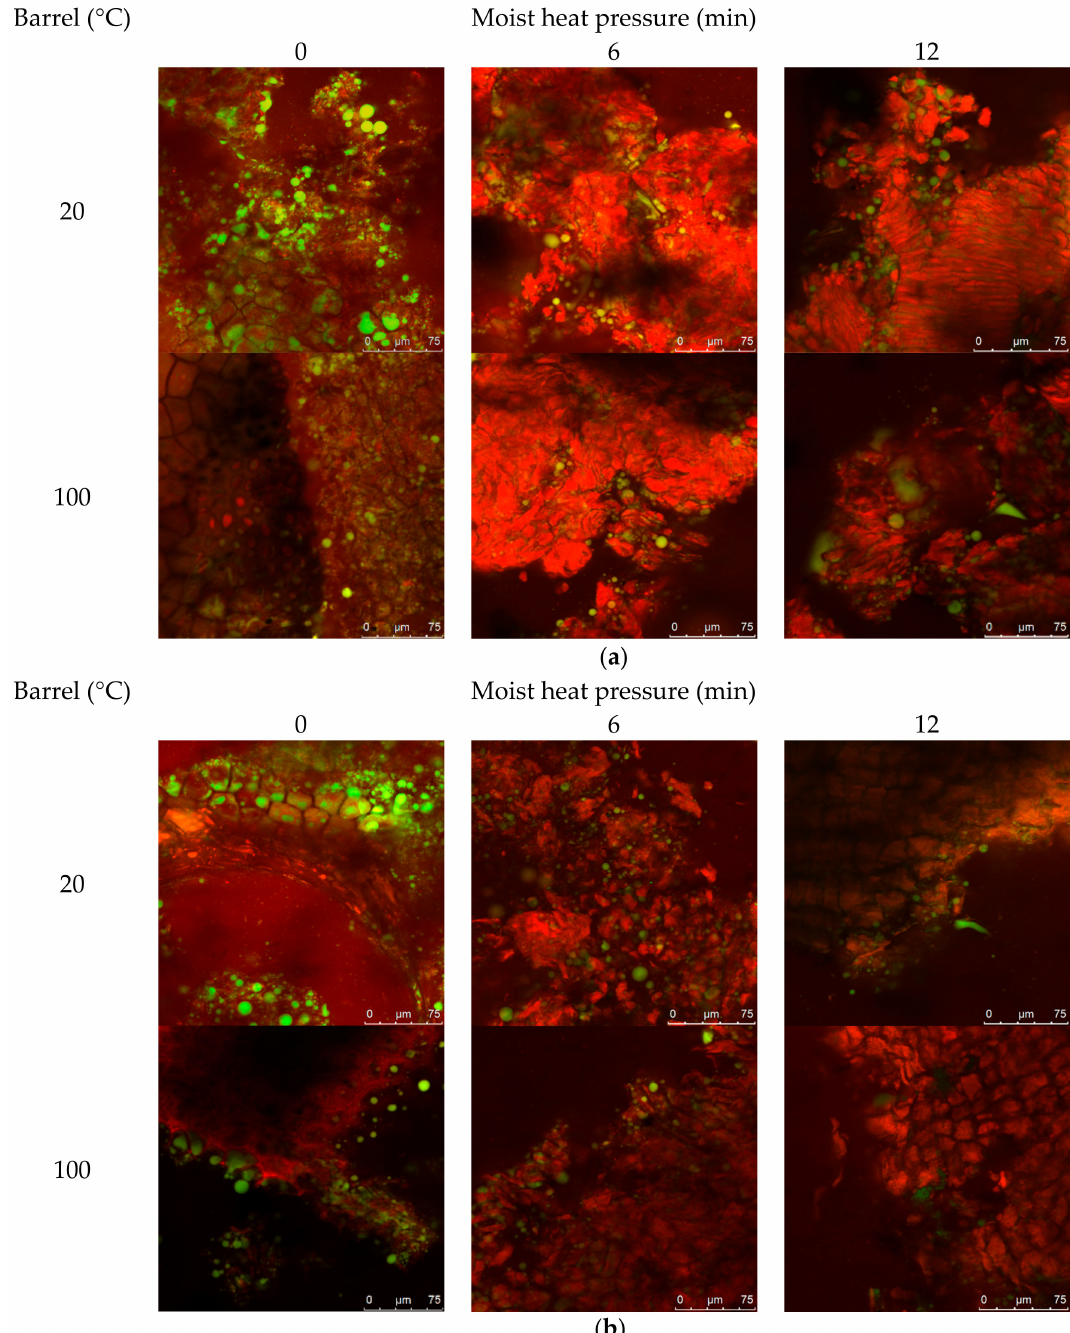
Figure 2. Representative confocal laser scanning micrographs of cold-pressed (20 ◦ C) and expeller (100 ◦ C) canola meal treated with increasing durations of moist heat pressure (( a ), 0, 6 and 12 min) and proteolytic digestion ( b ). Protein is stained red with Nile Blue dye, and lipid is stained green with Fast Green FCF dye. Scale bars correspond to 100, 75 or 50 µ